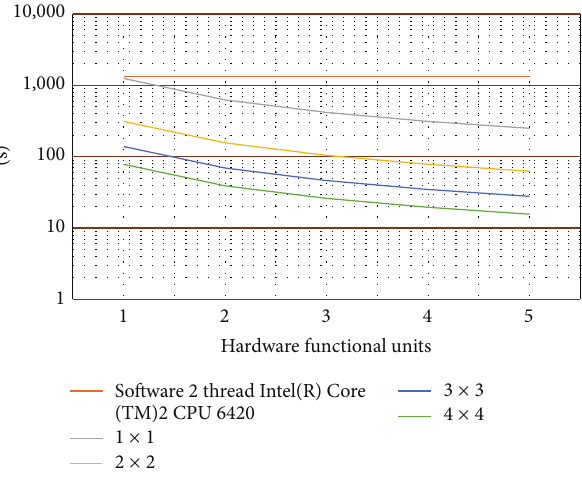
Figure 17: Time to compute (matrix 5000 × 5000 16